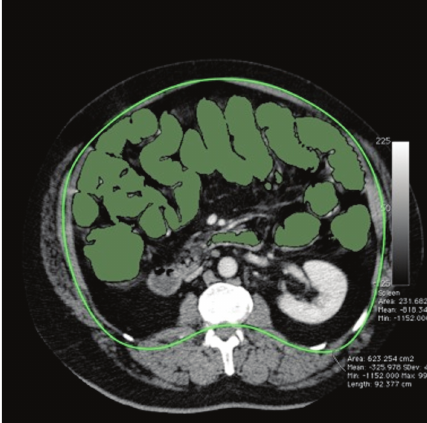
Figure 4: Axial CTC image through the mid-abdomen demonstrat- ing gross ileocecal reflux (green